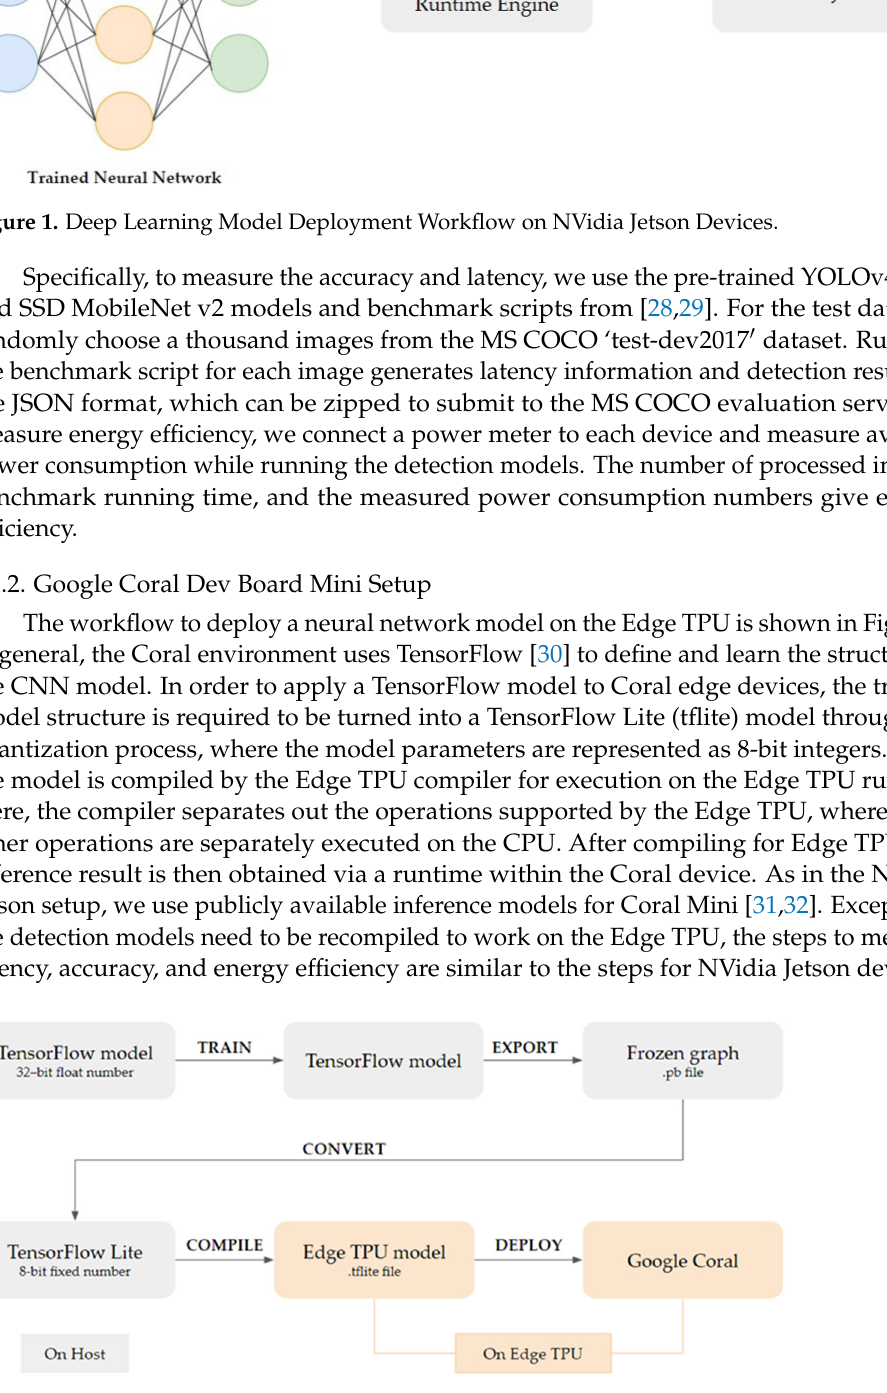
Figure 2. Deep Learning Model Deployment Workflow on Google Coral Dev